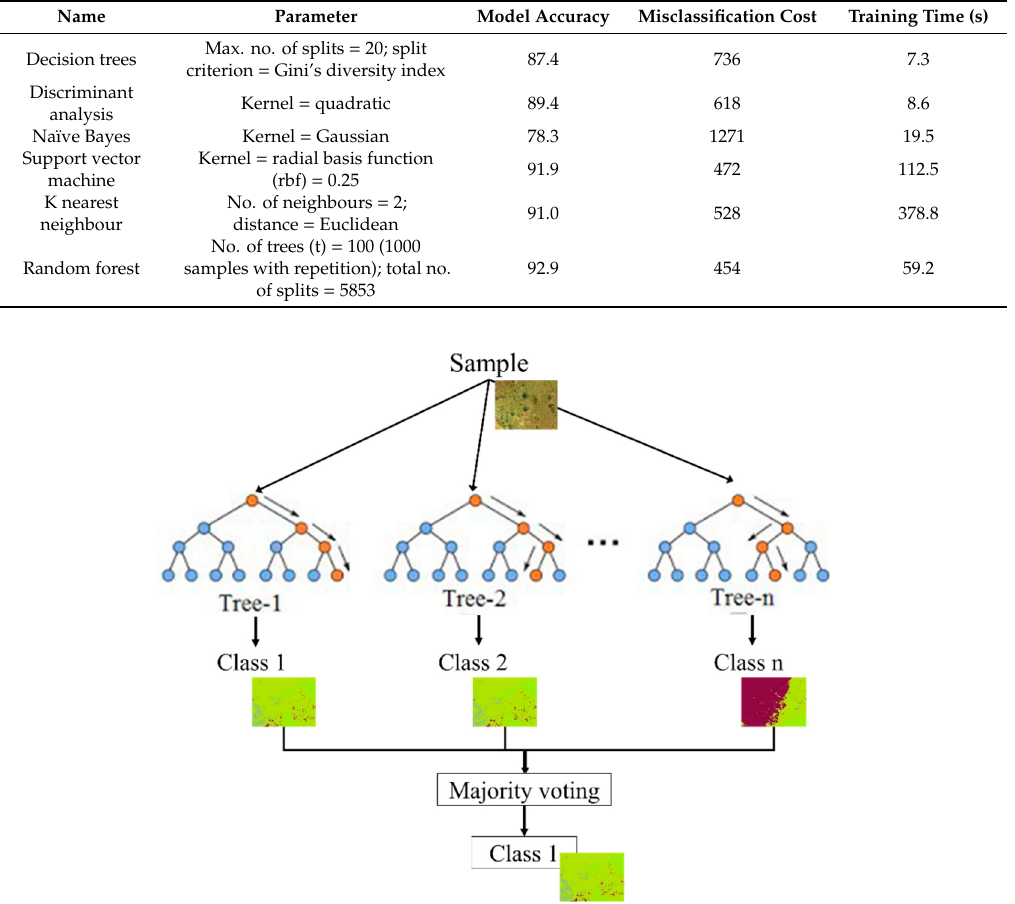
Table 2. Comparison of ML classification techniques.